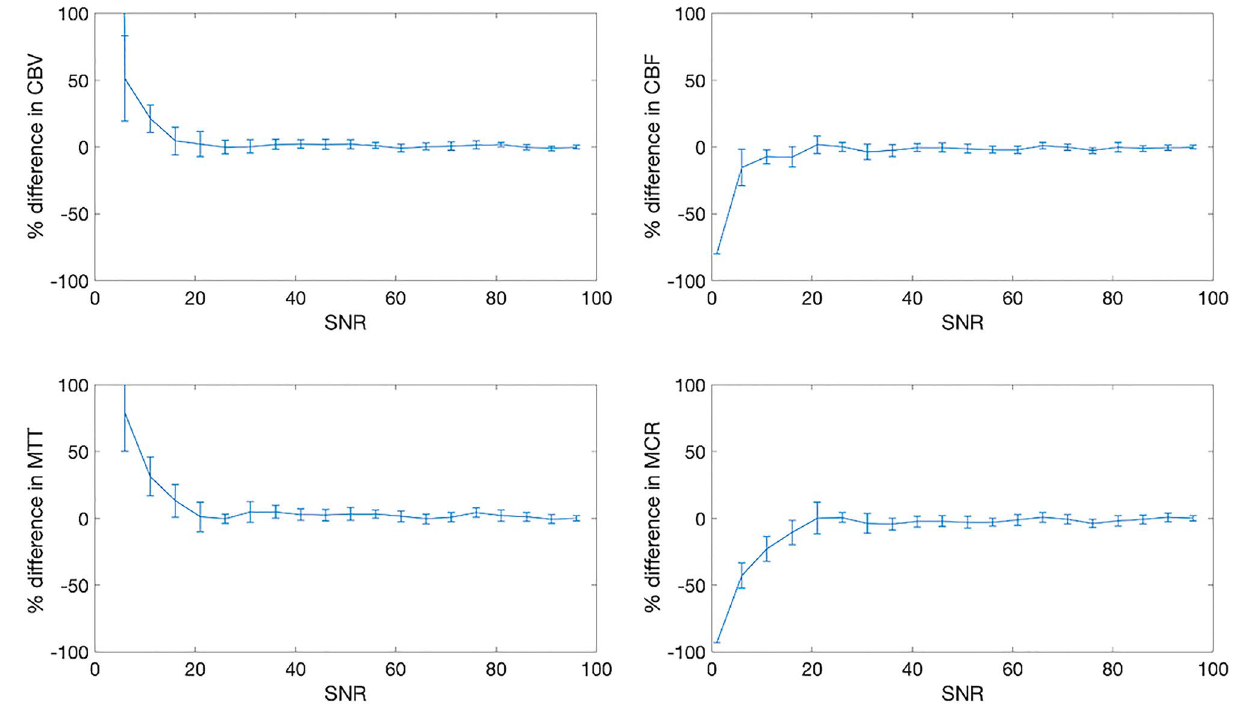
Figure 3. Simulation results demonstrating relative model stability down to SNR of 15 for all parameters. T